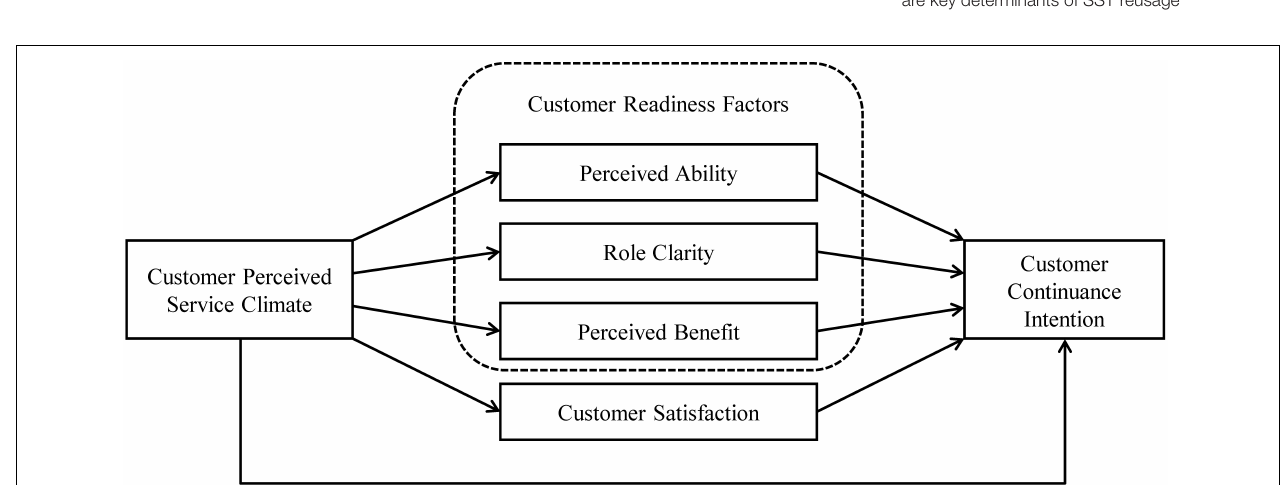
FIGURE 1 | Conceptual framework of customer continuance intention toward in-lobby